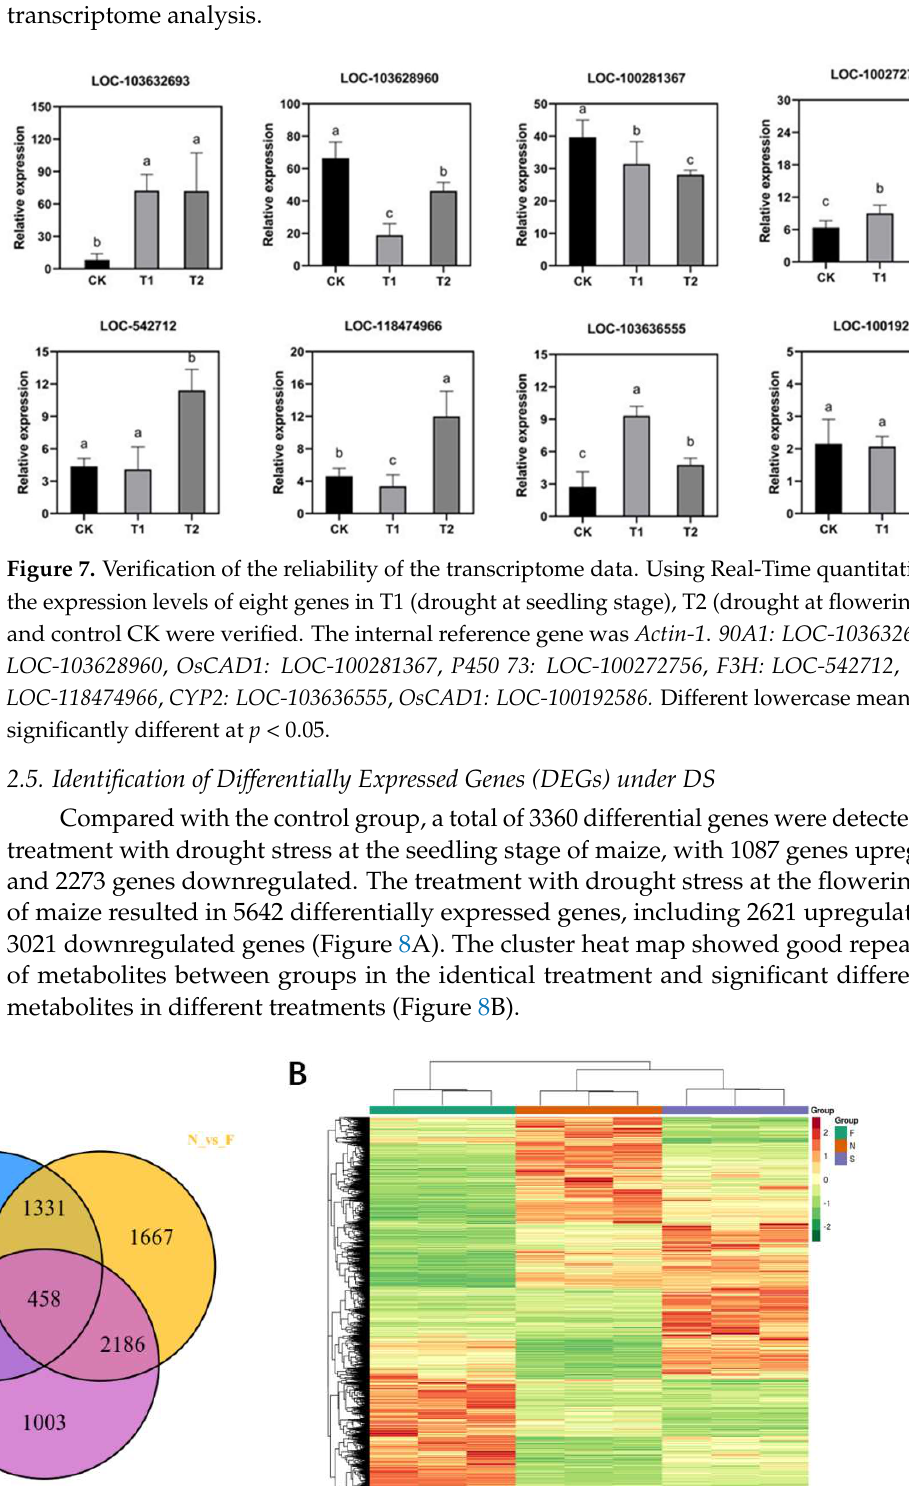
7 of 20 Figure 6. DAMs KEGG pathway enrichment between T1 and T2. 2.4. Overview of RNA-seq Data for T1 , T2 , and CK In order to study the transcription levels of maize under different drought conditions,